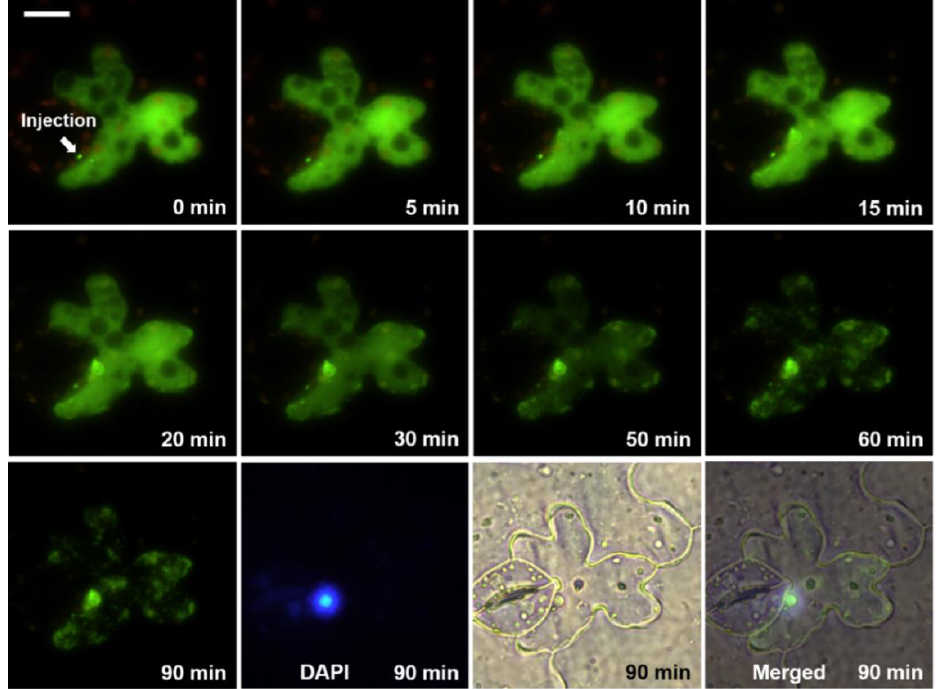
Figure 1. Time-course images of an abaxial leaf epidermal cell after microinjection of AF-488-labeled potato spindle tuber viroid (PSTVd; green): DAPI (blue) shows the nucleus and the white bar indicates 20 µ m. These images and similar photos are also presented in Video S1.